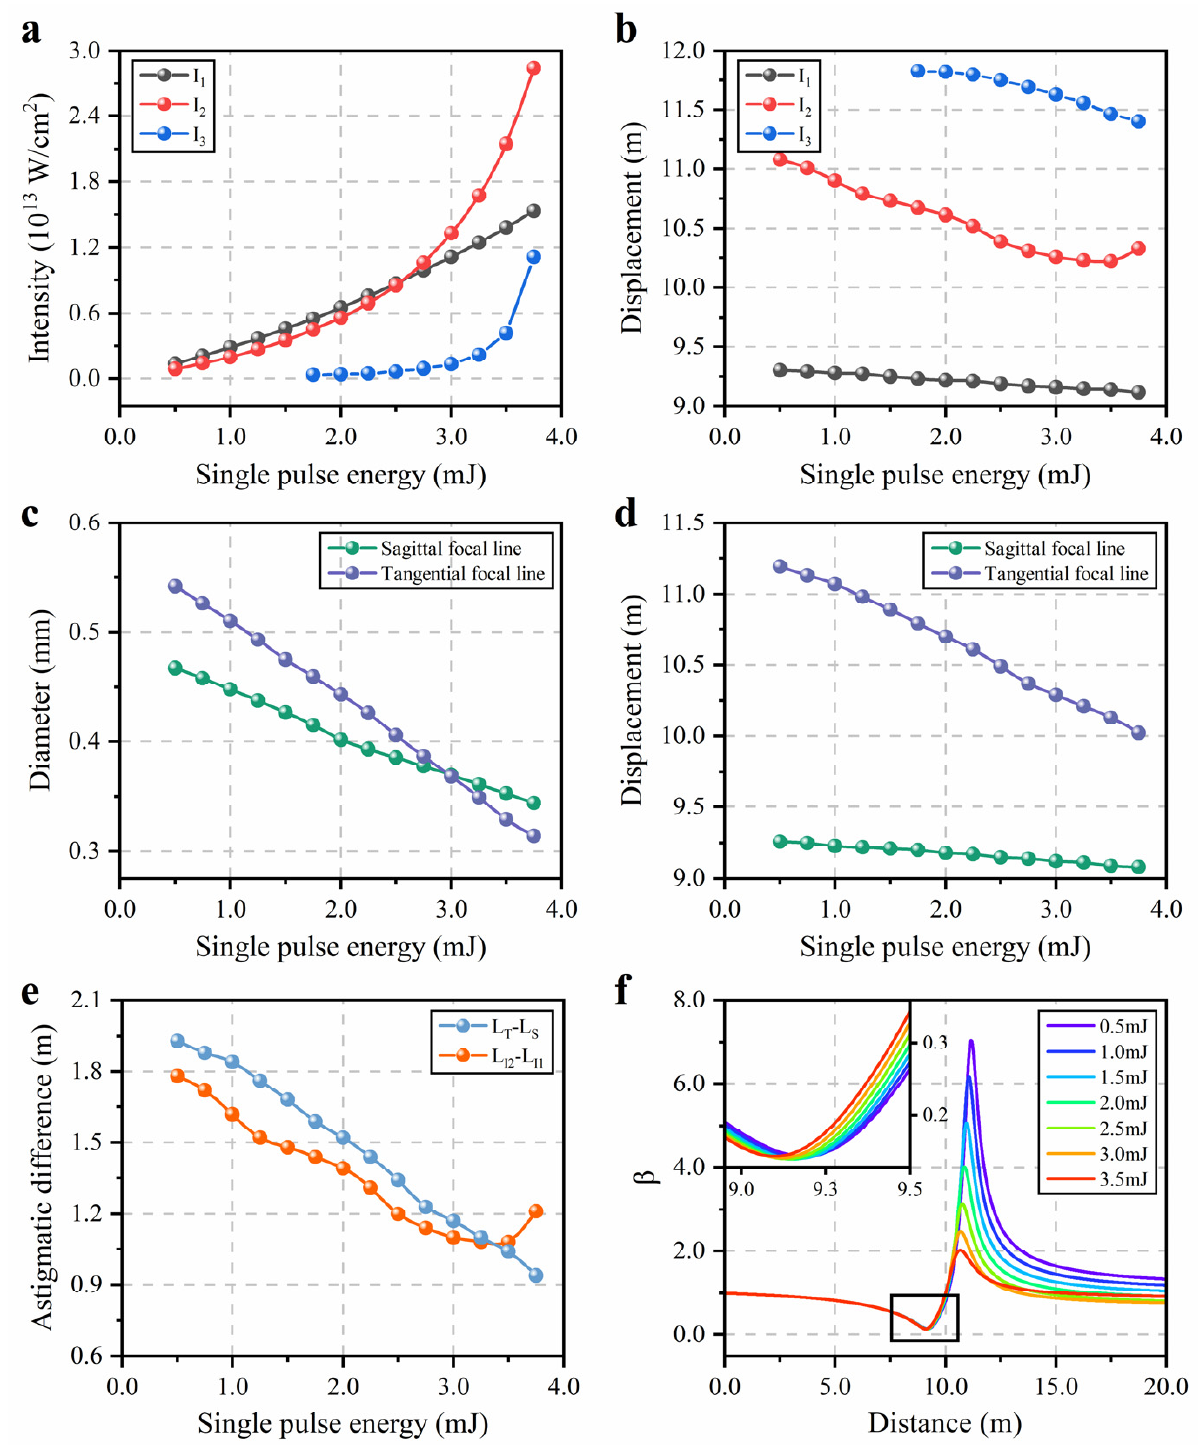
Figure 3. Focusing properties of the astigmatic Gaussian beams during filamentation: ( a ) Variation of the maximum on-axis intensities I 1 , I 2 and I 3 versus single pulse energies; ( b ) Displacement of I 1 , I 2 and I 3 versus single pulse energies; ( c ) Variation of diameter (FWHM) of the sagittal and tangential focal lines versus single pulse energies; ( d ) Displacement of the sagittal and tangential focal lines versus single pulse energies; ( e ) Astigmatic difference defined as distance between the sagittal and tangential focal lines and distance between I 1 and I 2 at different single pulse energies; ( f ) Variation of astigmatic parameter β as a function of propagation distance at different single pulse energies.